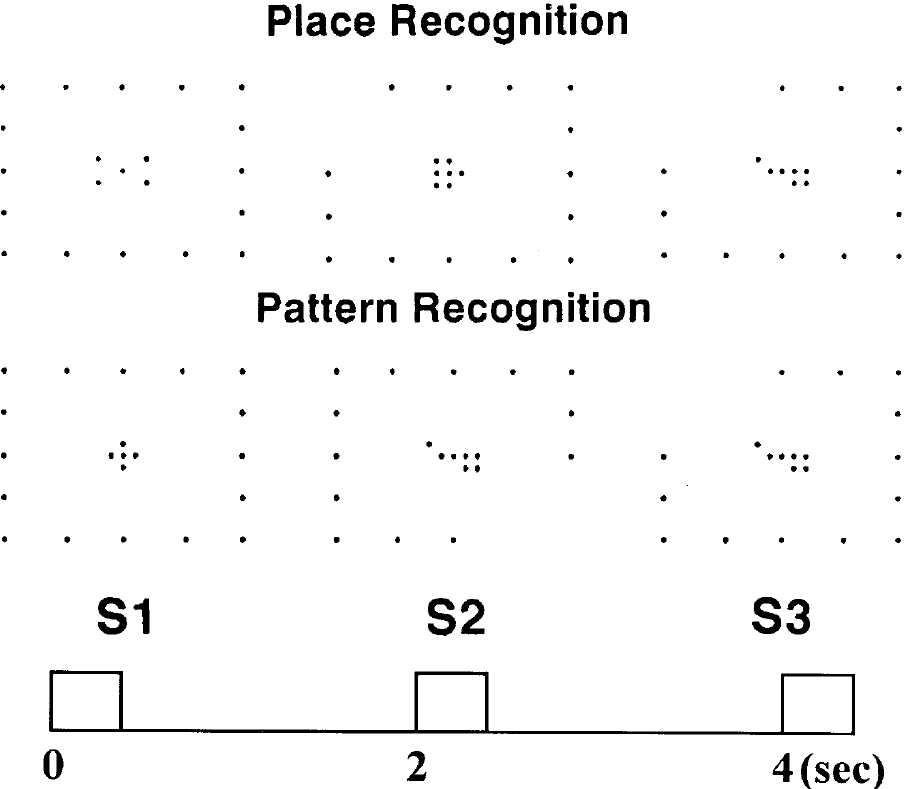
Fig. 1. Examples of stimuli used in the two types of trials. The warning stimulus (S1) was specific to each task. For more details see the text. Both trials shown above required ‘same’ as the correct